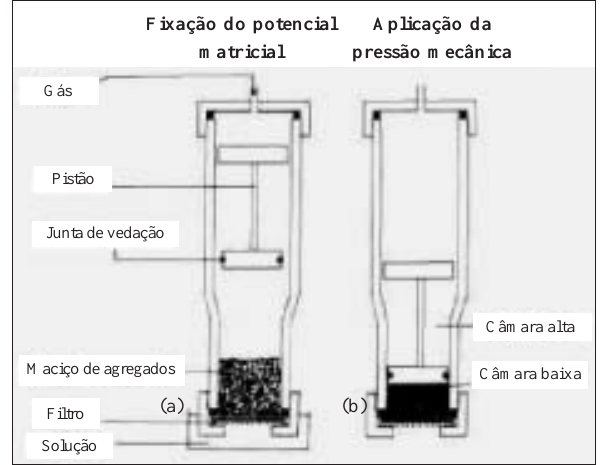
Figura 1. Dispositivo utilizado para o trabalho: (a) fixação do potencial matricial (Tessier & Berrier, 1979) e (b) aplicação de uma pressão mecânica uniaxial (Sala & Tessier,